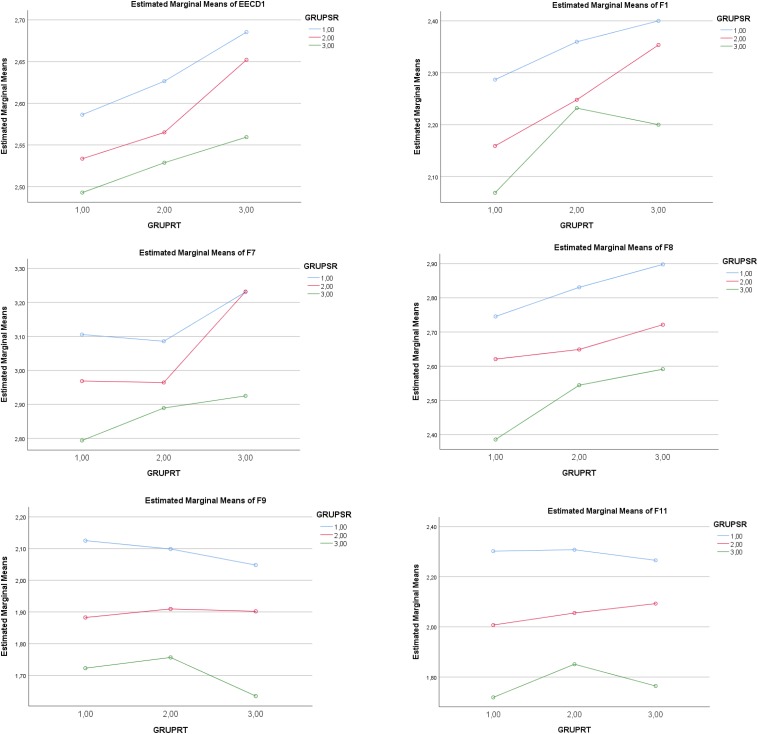
Graphic representation of the effect of low(1)–medium(2)–high(3) levels in the IV Self- Regulation (GRUPSR) and low(1)–medium(2)–high (3) levels in the IV Regulatory Teaching (GRUPRT) on Emotion-focused Coping Strategies (EECD1); EECF1. Avoidant distraction; EECF7. Reducing anxiety; EECF8. Preparing for the worst; EECF9. Emotional venting; EECF11. Resigned acceptance.